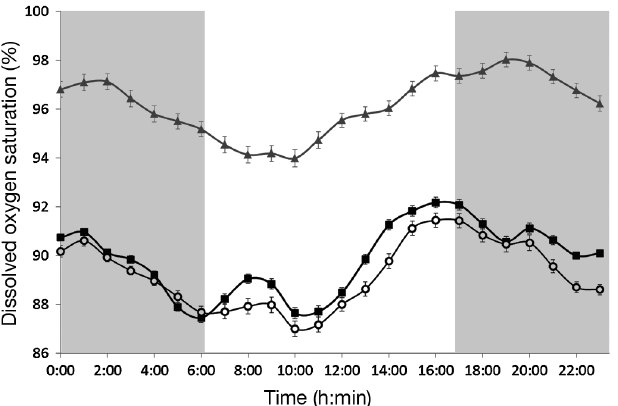
Fig. 4. Mean hourly dissolved O 2 saturation in each cage type and at the reference site. ( m ) Reference conditions, ( j ) stan- dard cages and ( s ) large cages. Error bars represent 95% confidence intervals. The grey shading denotes periods of darkness, while the unshaded area denotes daylight hours